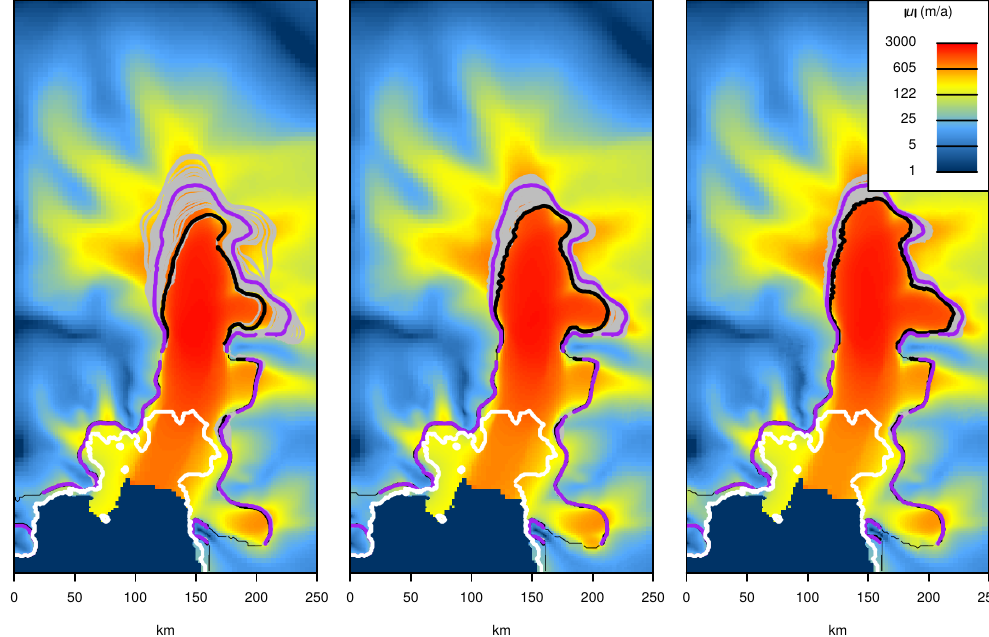
Figure 5. Location of PIG initial (white) and 200-year (grey) grounding lines and ice flow speed in the last simulation year for (left to right) the lower-, medium- and higher-frequency noise experiment. Ice flow speed is plotted for the simulations with the least retreat and corresponds to the black grounding line. The purple contour in each plot is the final grounding line of the noiseless experiment and the white contour is the initial grounding